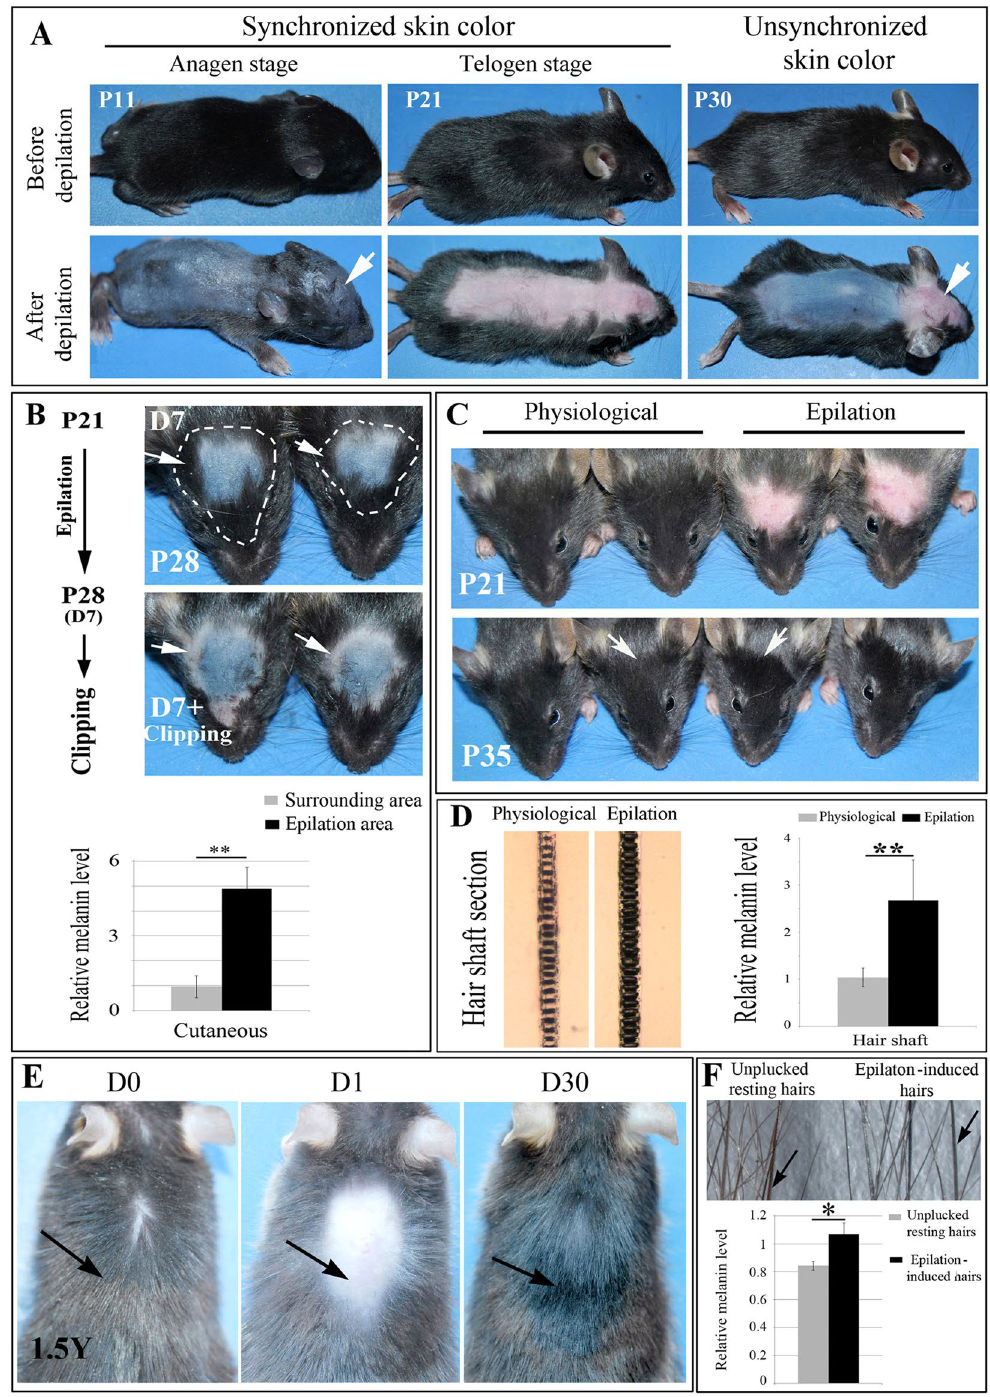
Figure 1. Epilation-induced skin and hair hyperpigmentation in C57BL/6 mice. ( A ) Images of control mice at the indicated ages before (upper panels) and immediately after (lower panels) hair clipping to reveal skin pigmentation. Note that during the first postnatal hair cycle, the colors of scalp and back skin differ. Arrows point to different color of scalp skin at P11 and P30. ( B ) Scalp of mice epilated at P21 and observed at P28 before (upper panels) or after clipping along the white dotted line (lower panels). Arrows point to the skin color of the clipped area. ( C ) Scalp hair pigmentation after epilation at P21. Note hyperpigmentation 14 days after epilation. Arrows indicate the different color between physiological hairs and epilation-induced regenerated hairs. ( D ) P35 scalp hair shafts and melanin levels from control mice and mice epilated at P21. ( E ) Back hairs of a 1.5 year-old mouse before and after epilation. Arrows indicate the change of hair color before and after epilation. ( F ) Back hair shafts (upper panel) and melanin levels (lower panel) from the epilated area and the surrounding area of a 1.5 year-old mouse 30 days after epilation. Arrows indicate the different color between physiological hairs and epilation-induced regenerated hairs. * Indicates p < 0.05, ** indicates p <